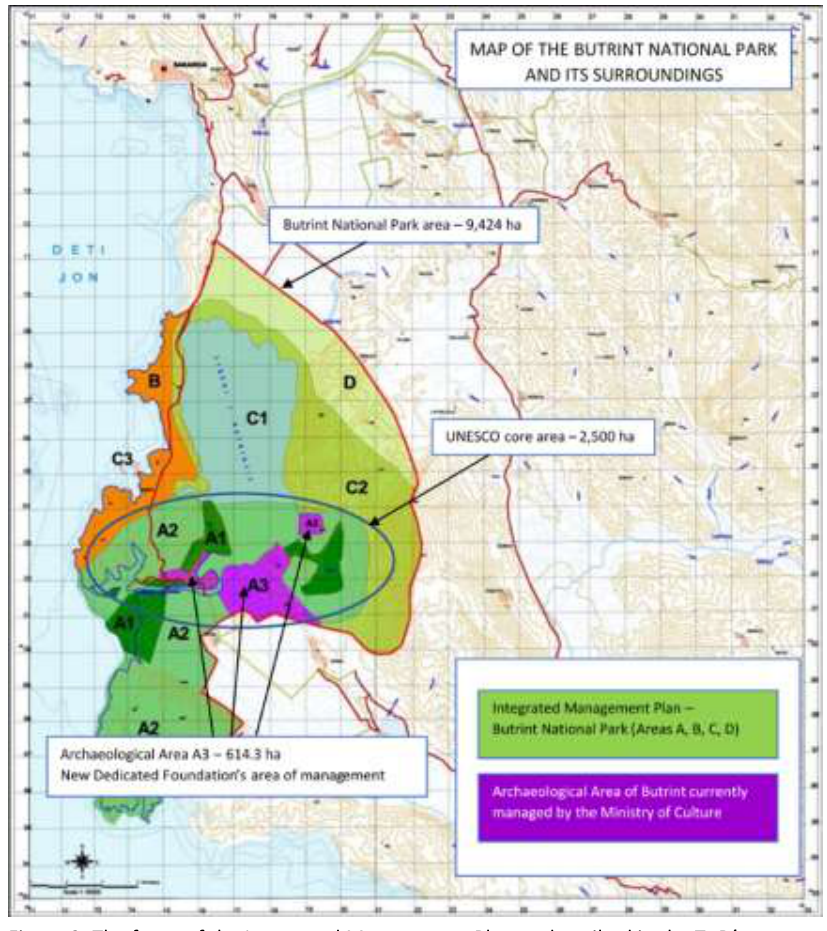
Figure 2: The focus of the Integrated Management Plan as described in the ToR